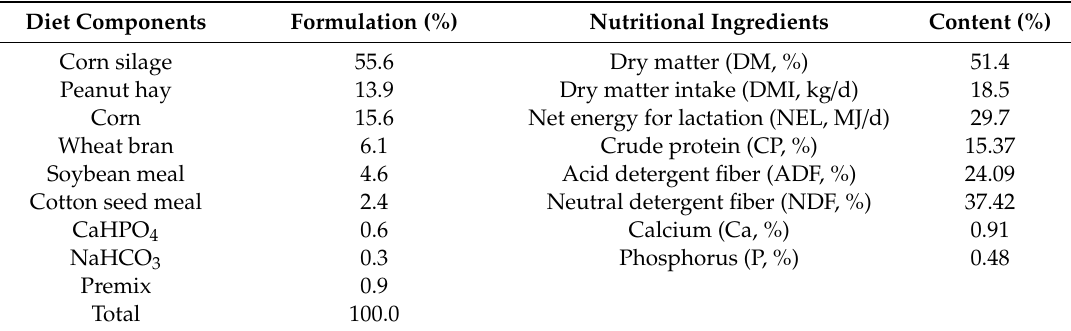
Table 1. Formulation and nutritional ingredients of standard